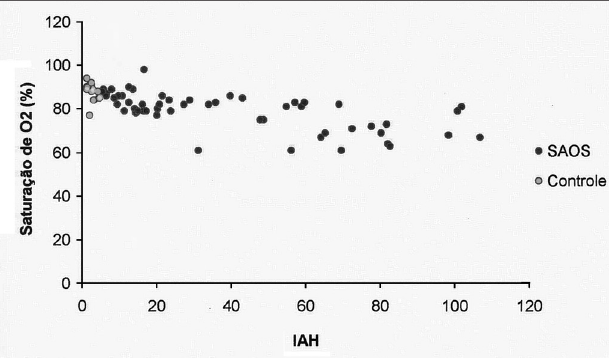
Figura 2. Distribuição da saturação média da oximetria, segundo o IAH nos dois grupos de